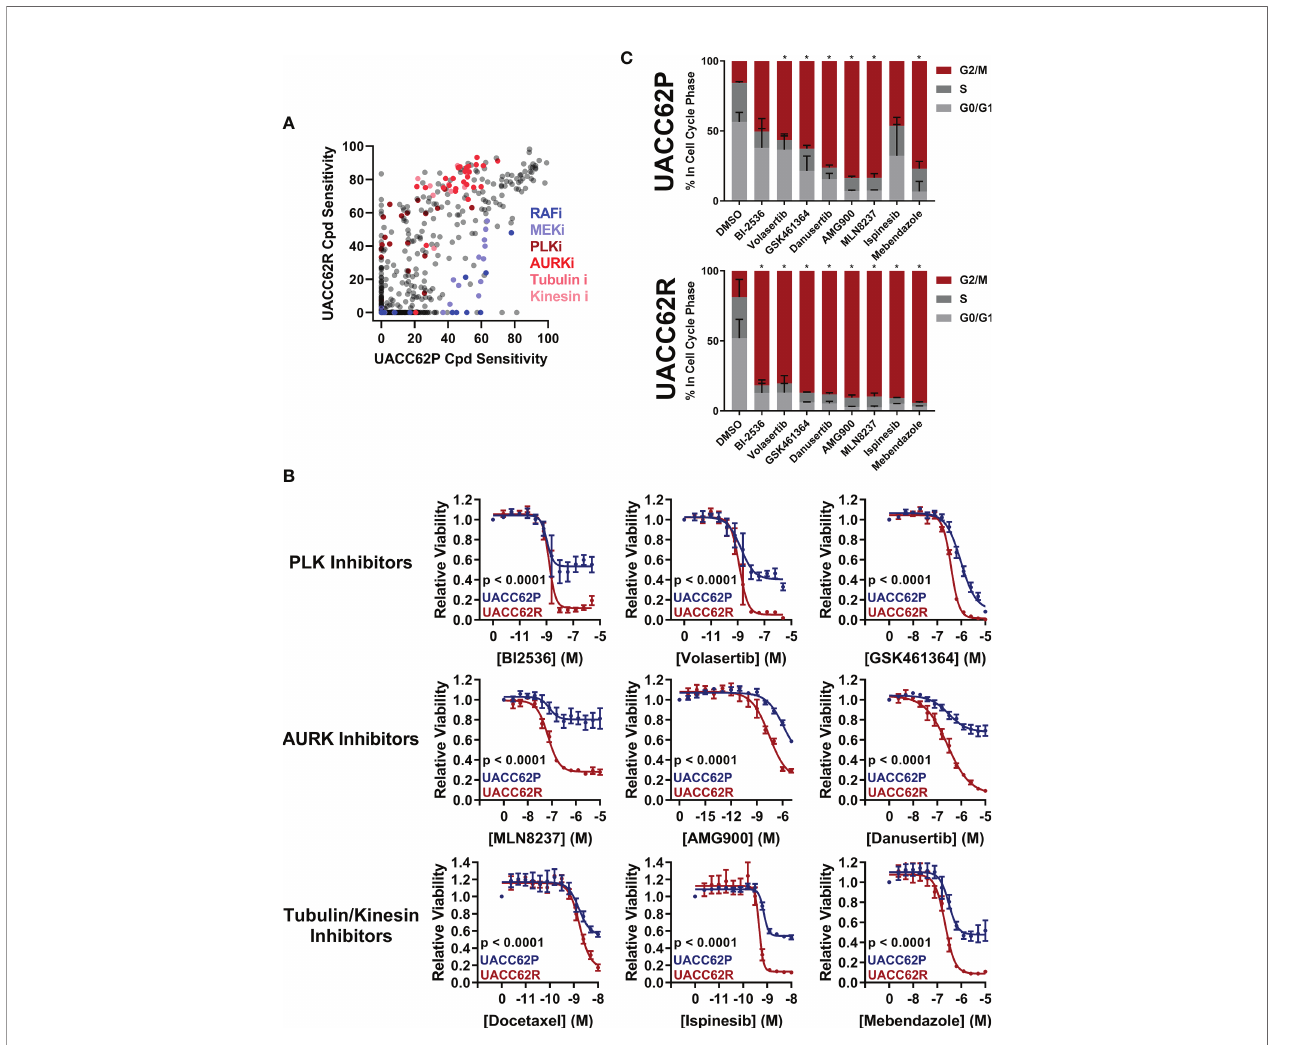
FIGURE 1 | Vemurafenib-resistant UACC62R cells are selectively vulnerable to pharmacological disruption of mitosis. (A) The NCATS MIPe chemical library was screened against parental (P) and Vemurafenib-resistant UACC62R cells at 200 nM as described in the Materials and Methods section. Compound sensitivity data are plotted as % reduction in viability of UACC62P cells vs UACC62R cells for each compound in the screen. The larger the sensitivity value, the greater was the reduction in cell viability. The screen was performed with n = 1 replicates for each cell line. Inhibitors with selected targets are indicated in shades of blue for those that showed greater ef fi cacy in UACC62P cells, and in shades of red for those that showed greater ef fi cacy in UACC62R cells. (B) Fresh powder for selected compounds identi fi ed in the initial screen was obtained and the effect of these compounds on cell viability was analyzed at the indicated concentrations. Blue lines represent data for the UACC62P cells, and red lines indicate data for UACC62R cells. Data are represented as mean ± SE of the technical replicate averages (n = 3) for each of the biological replicates (n = 3). IC 50 and E max values are listed in Supplementary Table S3 . (C) Cell cycle analyses of vehicle and drug-treated UACC62P/R cells were performed as described in the Materials and Methods section. All compounds were used at concentrations of 1 µM except for Ispinesib which was analyzed at 1 nM. Statistical analyses were performed on the proportion of cells in G2/M and in S phases for the drug-treated samples vs the DMSO control using one-way ANOVA analysis, * indicates p < 0.01. Data are represented as mean ± SE for n = 3 biological